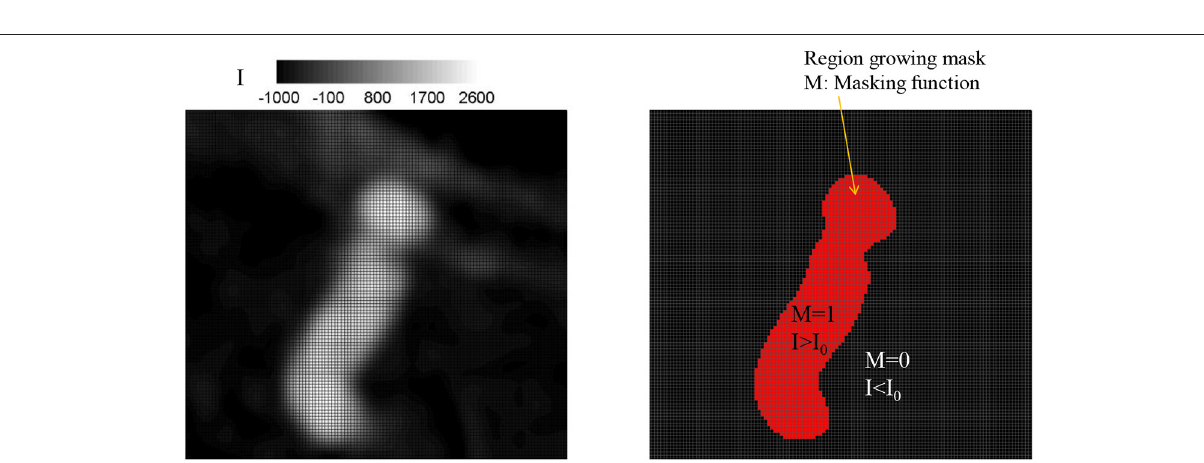
FIGURE 2 | Identifying lumen region by a region growing algorithm. (Left) Original grayscale image with the intensity (I). (Right) Identified lumen with the threshold intensity, I 0 = 500. The region for which intensity, I, greater than the threshold, I 0 is identified as lumen and the masking function value M is set to 1; otherwise M =